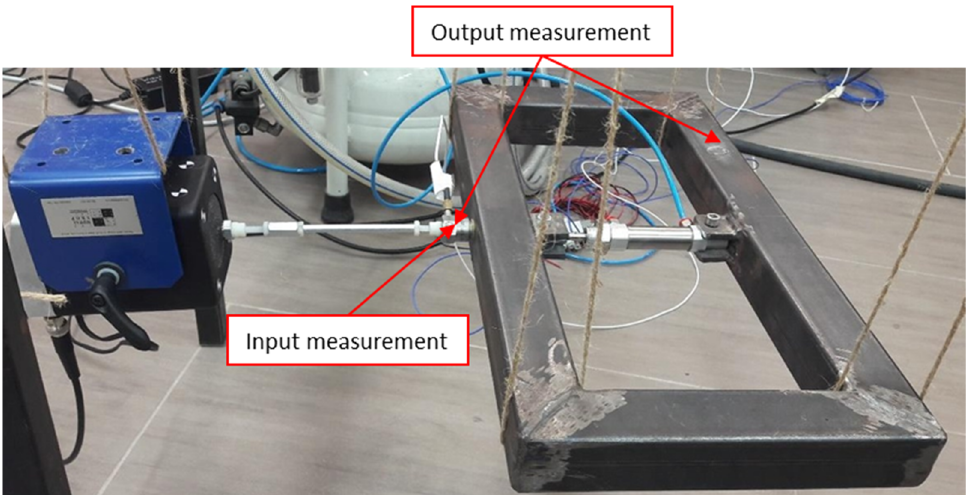
Figure 4. Frame structural element and experimental damage detection